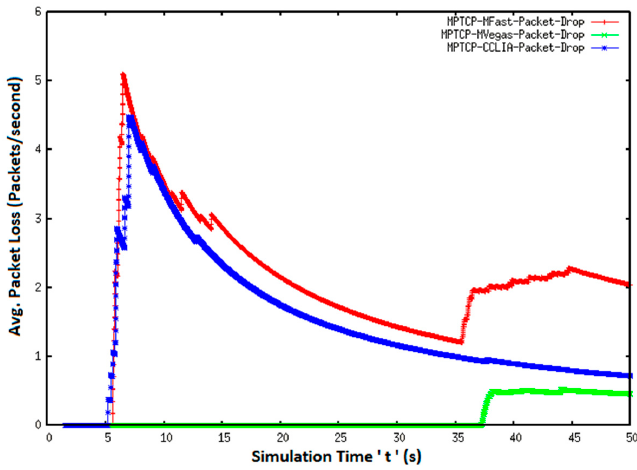
Figure 7. Average packet loss rate of Setup 1.